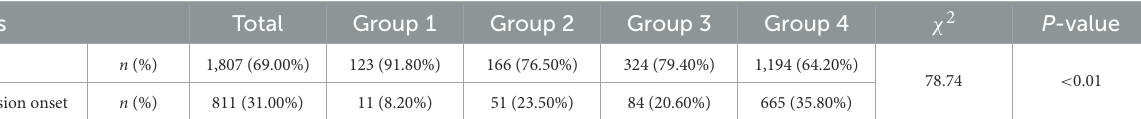
TABLE 2 Crude prevalence of hypertension onset in four groups.